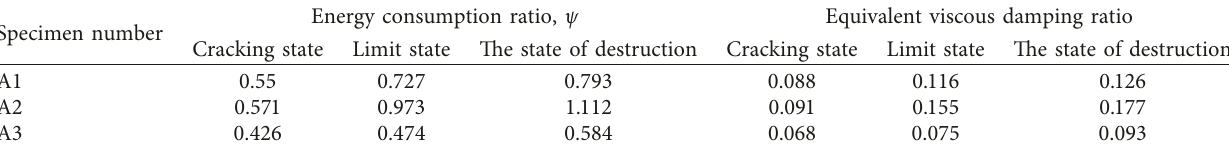
Table 6: Sample energy dissipation ratio and equivalent viscous damping